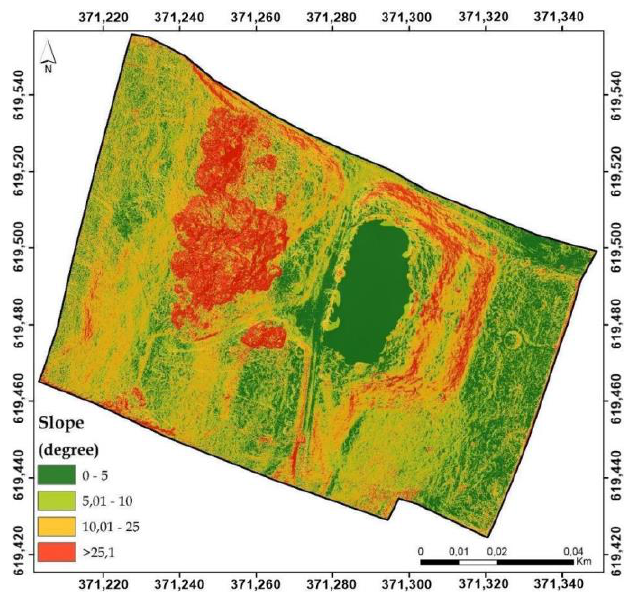
Figure 15. Slope illustration.